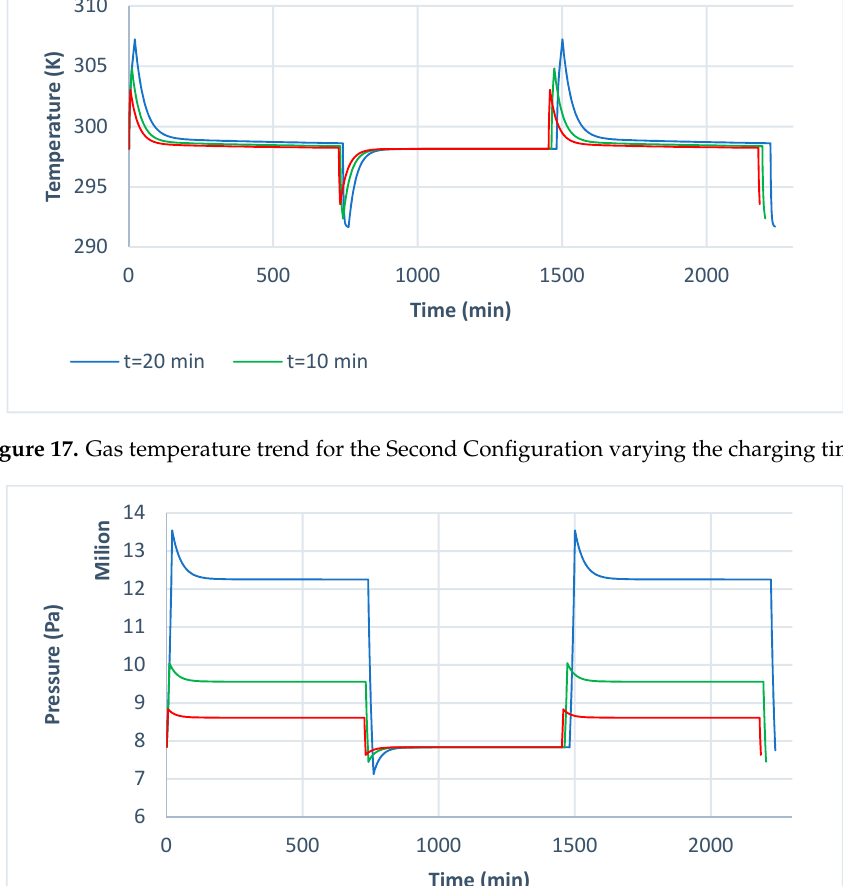
Figure 16. Gas temperature trend for the First Configuration varying the charging time.